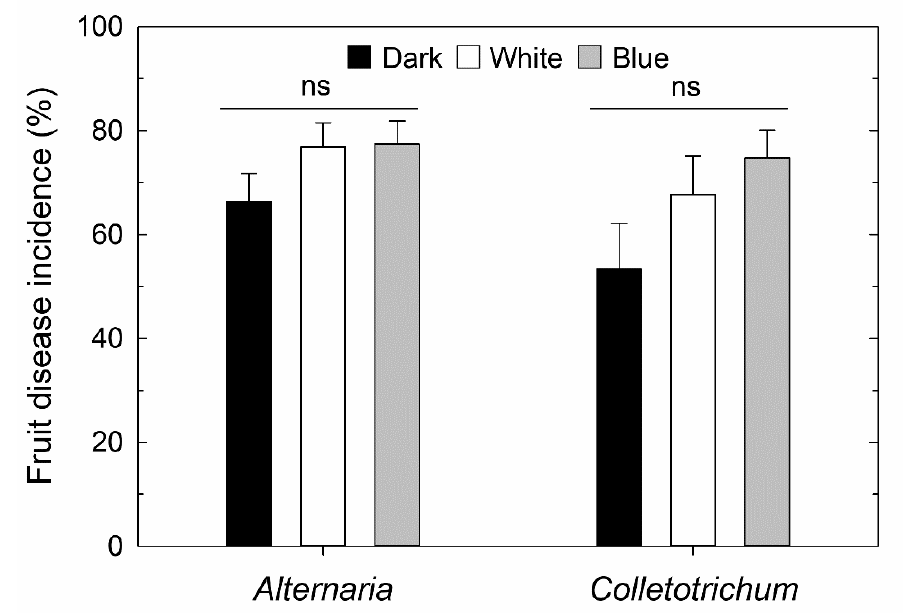
Figure 3. Postharvest disease incidence (percentage of affected fruit) in ripe ‘Star’ southern highbush blueberry fruit inoculated with Alternaria tenuissima and Colletotrichum acutatum under three light treatments in cold storage. Fruit were incubated under the light treatments for 4 days prior to inoculation and 9 days after inoculation, followed by another 4 days at room temperature under ambient light. Values are means and standard errors of four replicate groups of fruit per treatment. One-way analysis of variance was performed between the three treatments (blue, white and dark) separately for each pathogen. Differences were non-significant (α = 0.05).